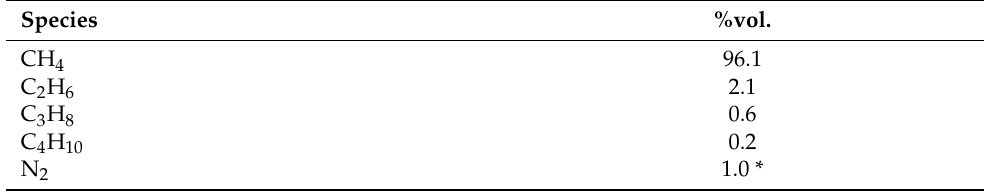
Table 1. Composition of natural gas.